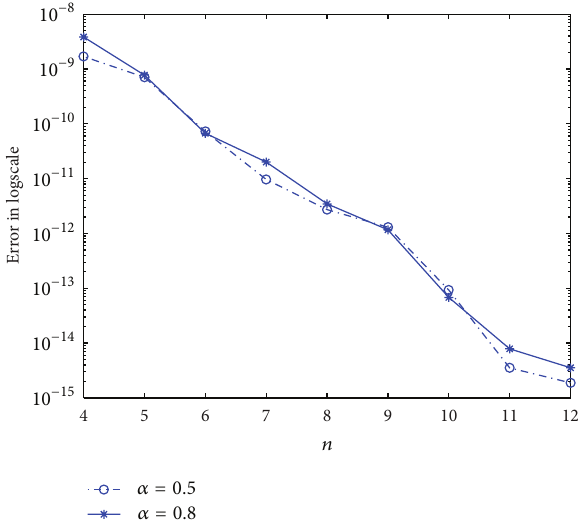
Figure 1: The errors for different 𝑛 and 𝛼 in Example